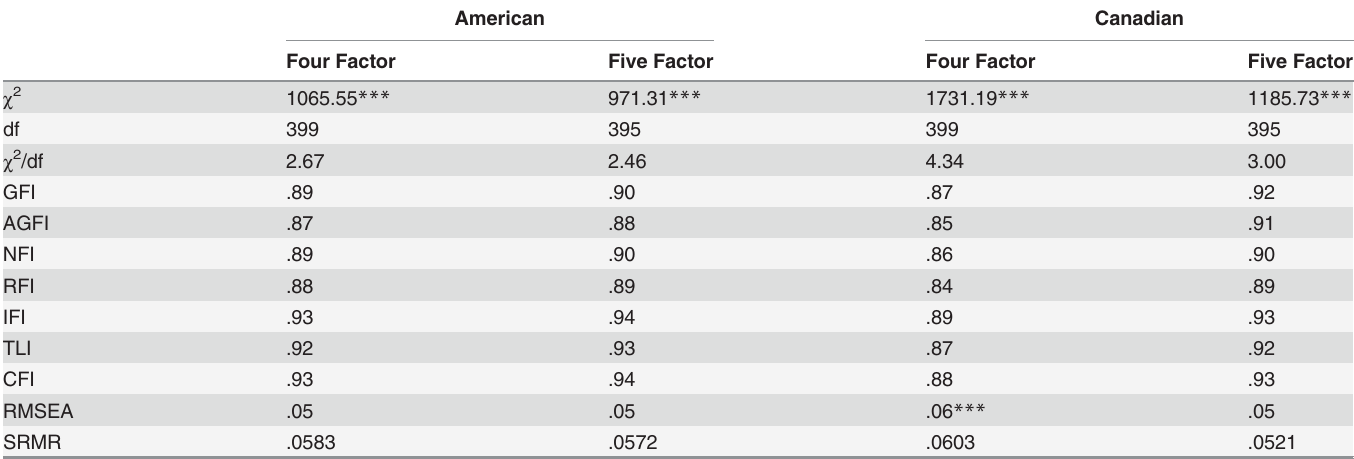
Table 11. Goodness of Fit Statistics for Con fi rmatory Factor Analysis Results for Fully Correlated Four and Five Factor Models for the ESI-R for American and Canadian Samples. American Canadian Four Factor Five Factor Four Factor